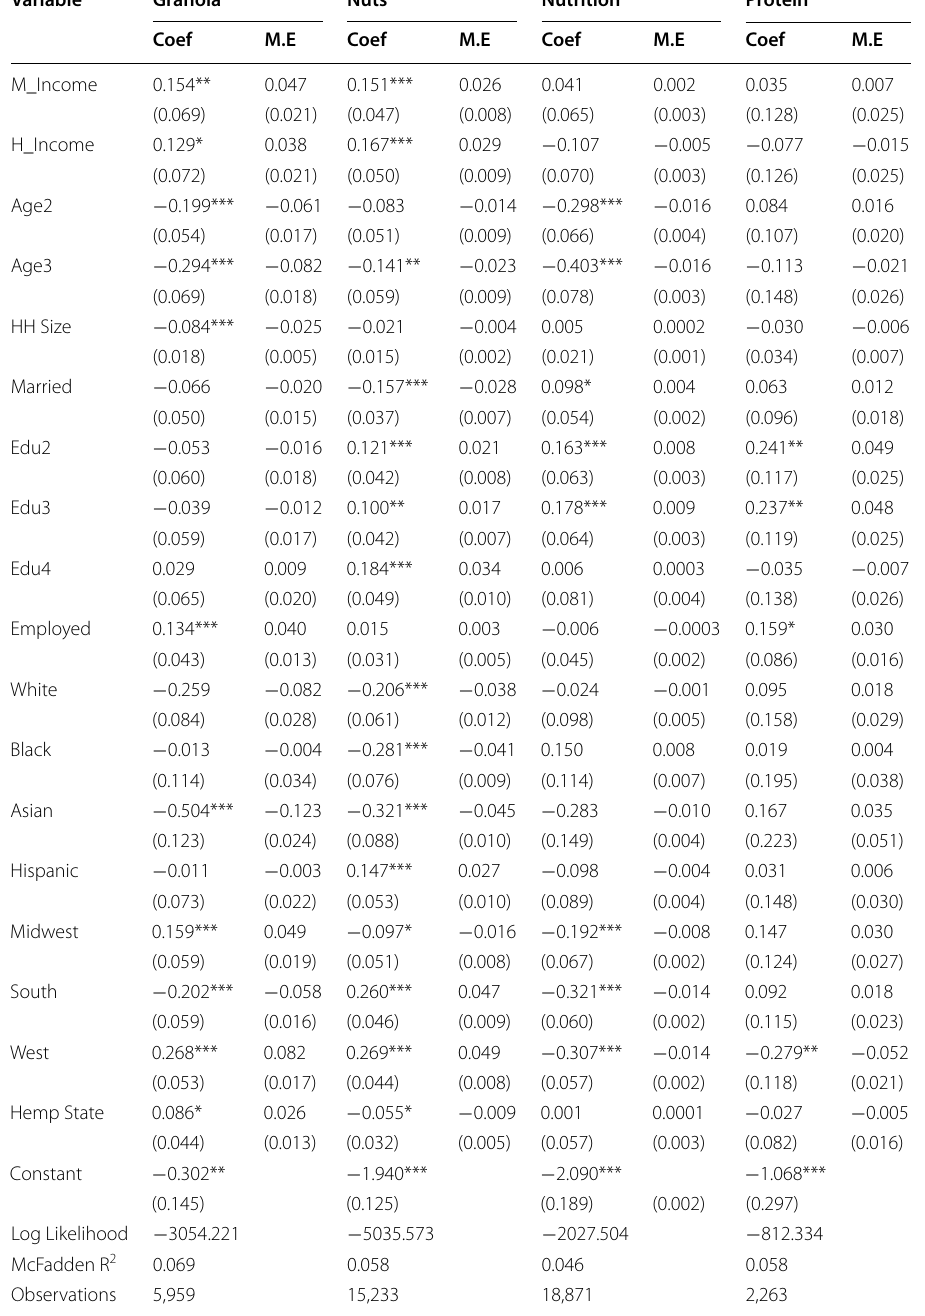
Table 4 First-stage probit estimation